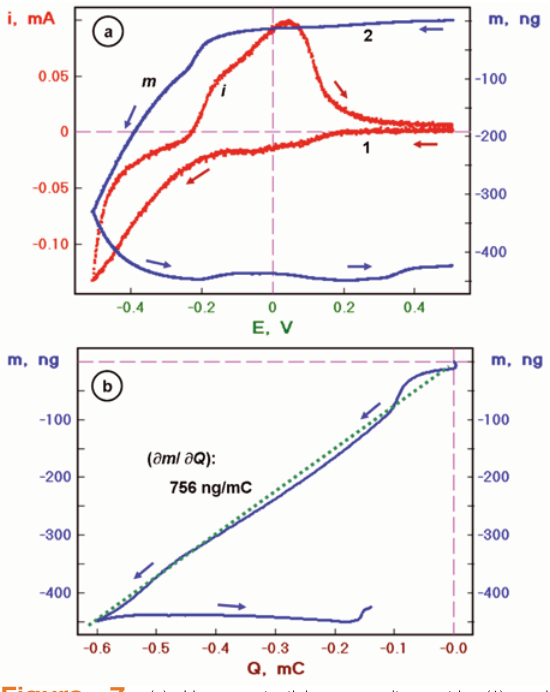
Figure 7. (a) Linear potential scan voltammetric (1) and nanogravimetric (2) characteristics for a WO piezoelectrode in 100 mM TEAC solution; (b) m-Q